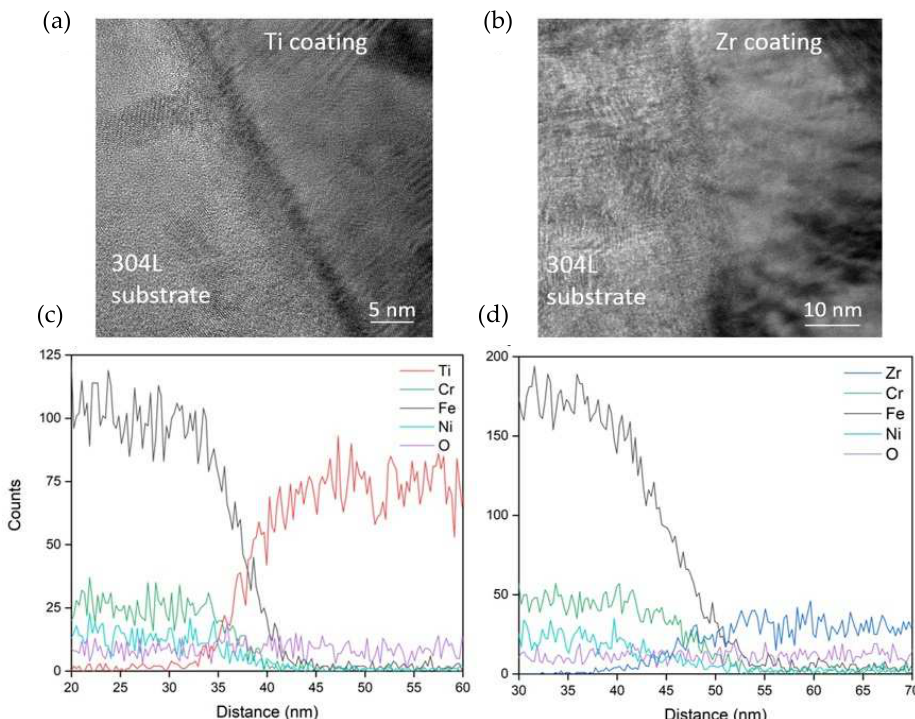
Figure 5. TEM observation of the substrate/metallic bond coat interface of ( a ) Ti + -etched + Ti-coated and ( b ) Zr + -etched + Zr-coated samples and TEM profiles for ( c ) Ti + -etched + Ti-coated and ( d ) Zr + -etched + Zr-coated samples.